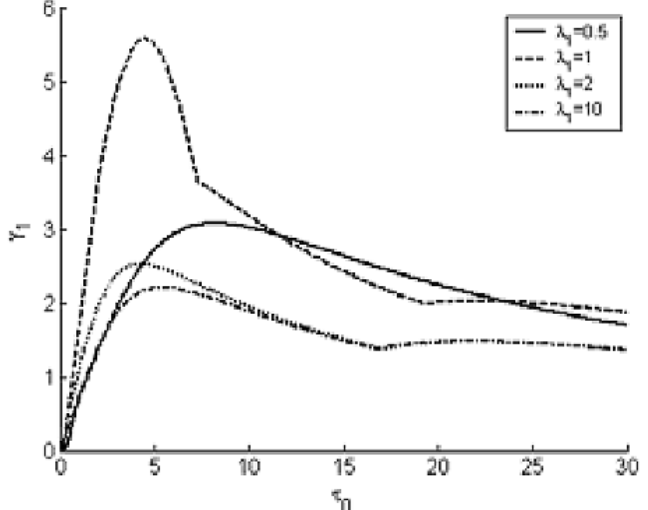
(cid:1)(cid:1) = 0 . 5 , λ 2 = 0 . 1 , ζ 1 = 0 , ζ 2 = 0 . 0 m